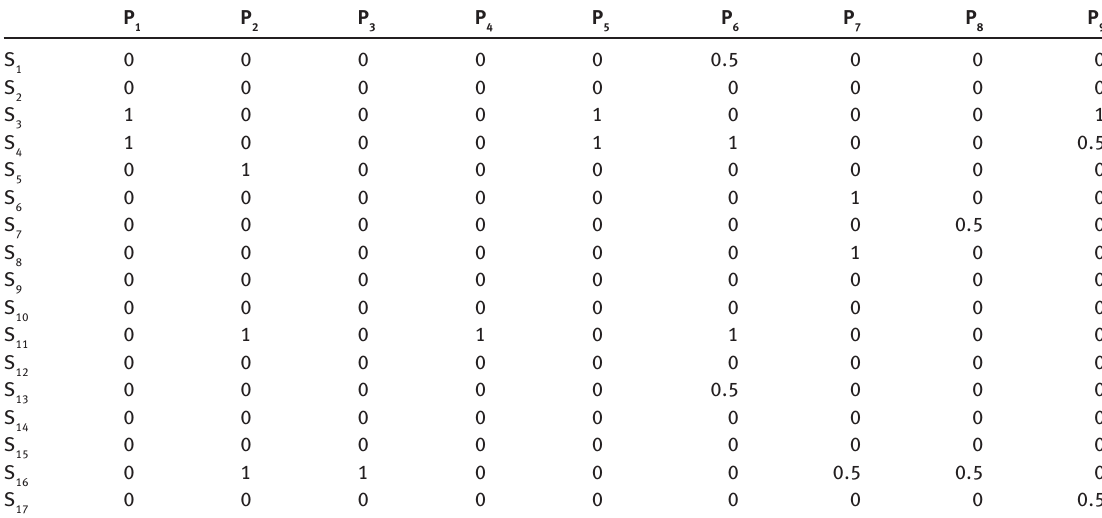
Table 2: Patient-Symptom Relation (Case Study Example).